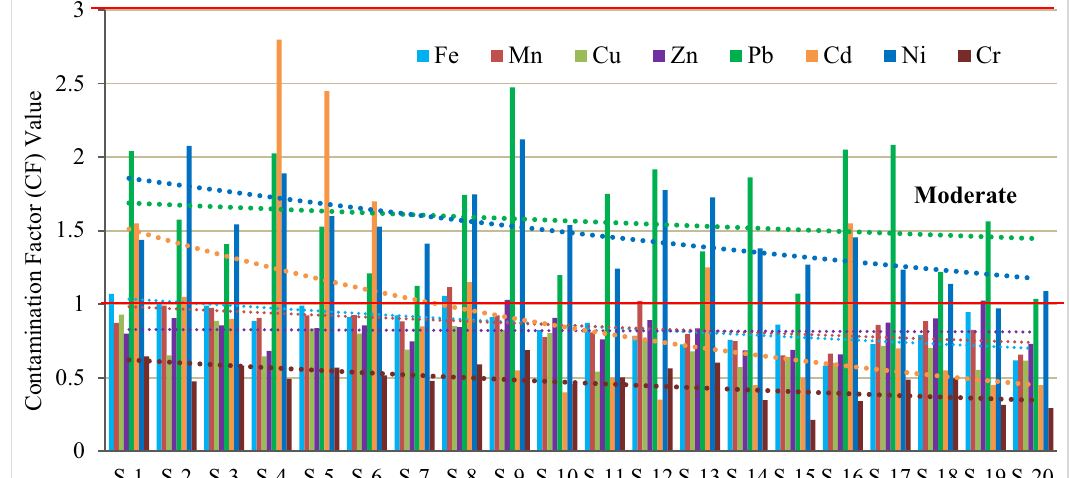
Figure 7. Contamination factor (CF) values of eight trace metals in studied Sundarbans soils.